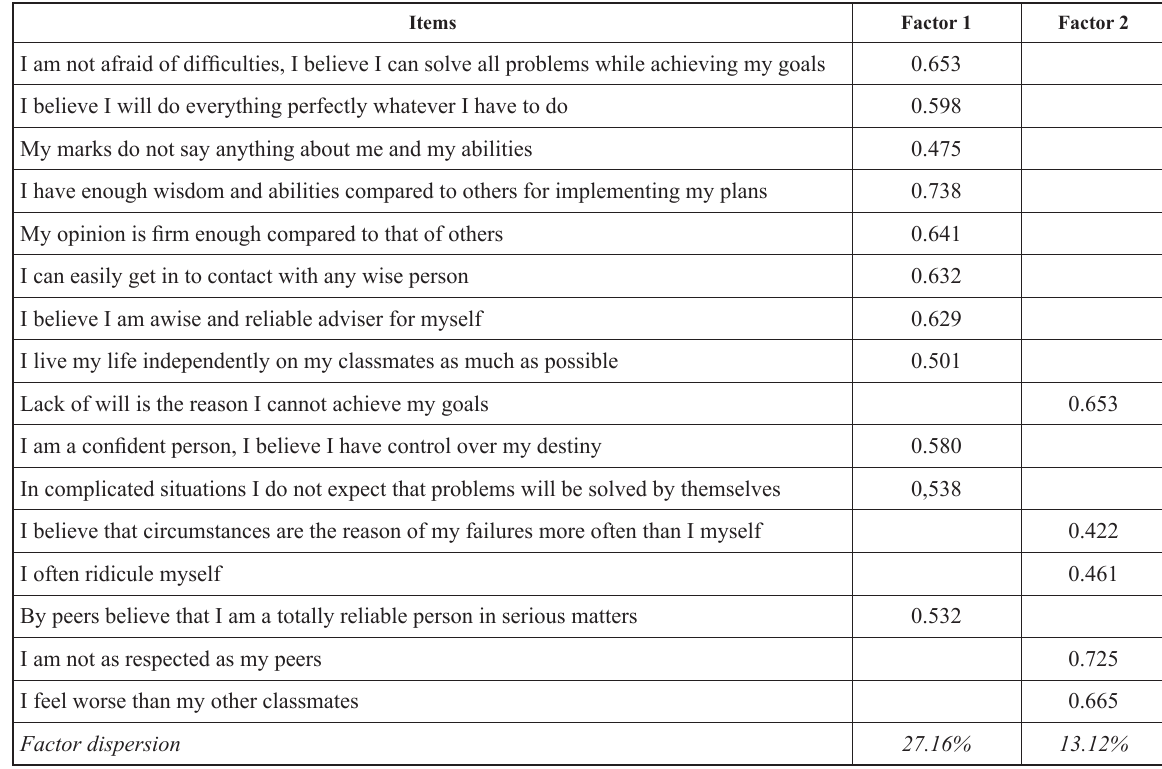
Table. Items featuring self-esteem and self-confidence, factor loadings